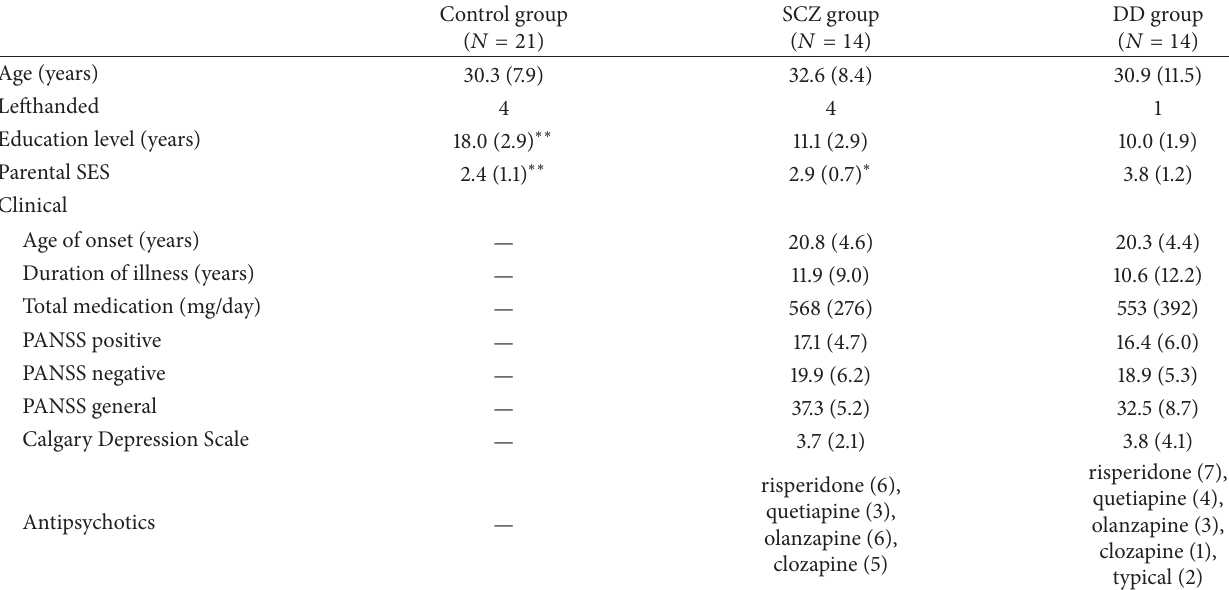
Table 1: Sociodemographic and clinical data.